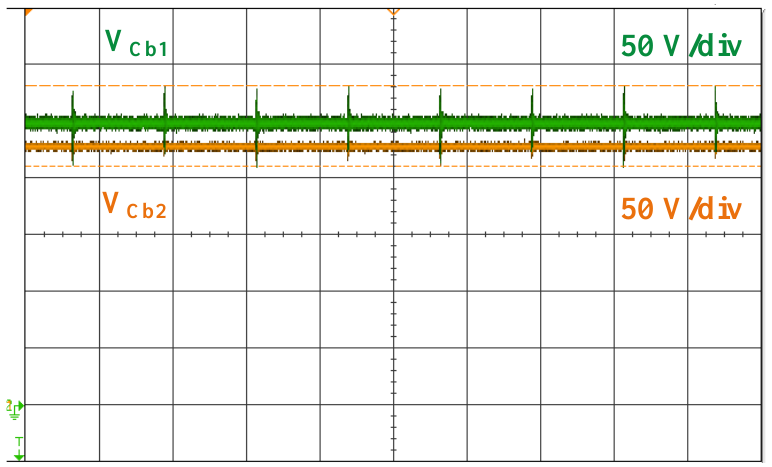
Figure 17. Half-Bridge input capacitors voltage V Cb1 and V Cb2 difference, due to the unequal capacitive loads.